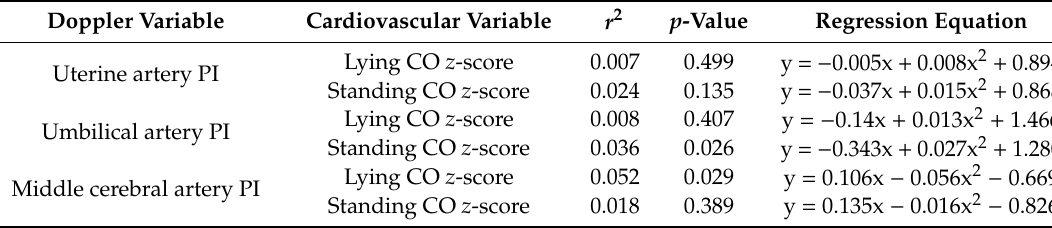
Table 4. Association between cardiac output and Doppler pulsatility indices. Doppler Variable